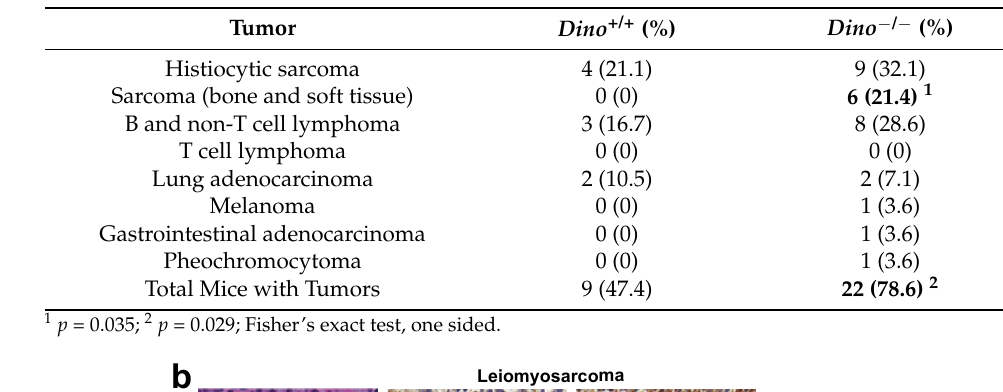
Table 1. The spectrum of spontaneous malignant tumors in Dino +/+ and Dino − / − mice.